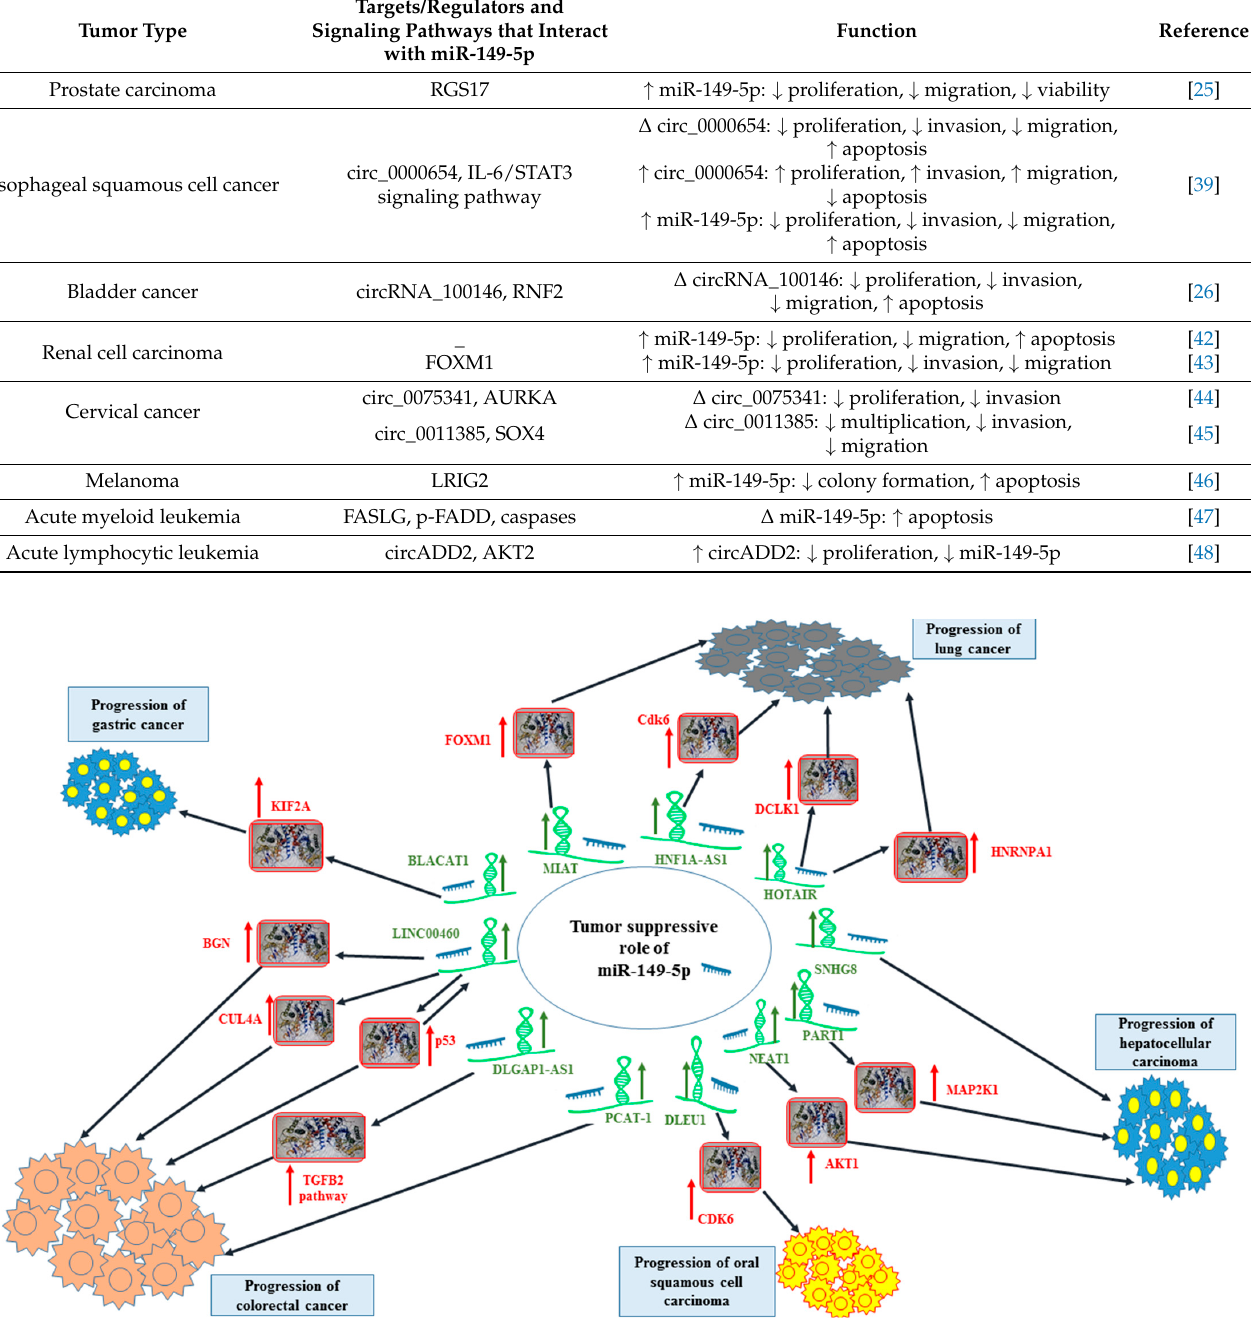
Table 1. Role of miR-149-5p or miR-149-5p-interacting genes in carcinogenesis based on cell line